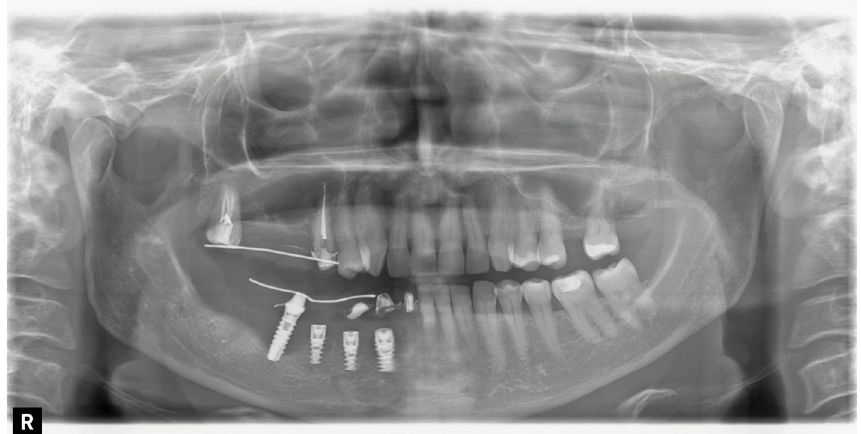
Figure 4: Insertion of three titanium